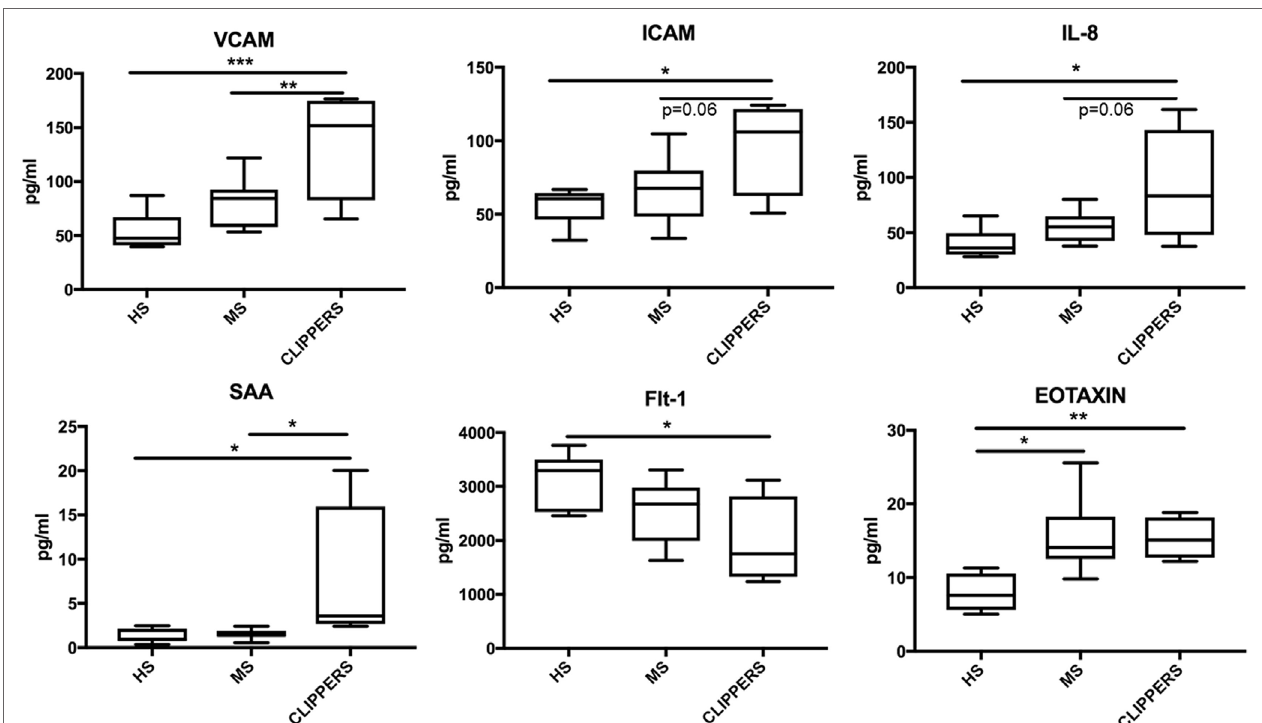
FigUre 6 | Molecular markers in the cerebrospinal fluid (CSF) of patients with chronic lymphocytic inflammation with pontine perivascular enhancement responsive to steroids (CLIPPERS) compared to patients with relapsing MS and healthy subjects. Quantitative Mesoscale V-PLEX 37 human assay: differentially expressed biomarkers in the CSF samples from patients #1–4, compared to relapsing-remitting multiple sclerosis (RMS; n = 9) and healthy subjects (HS; n = 7). Error bars indicate SD. * p < 0.05; ** p < 0.01, ** p < 0.001, one-way ANOVA with Tukey multiple comparison